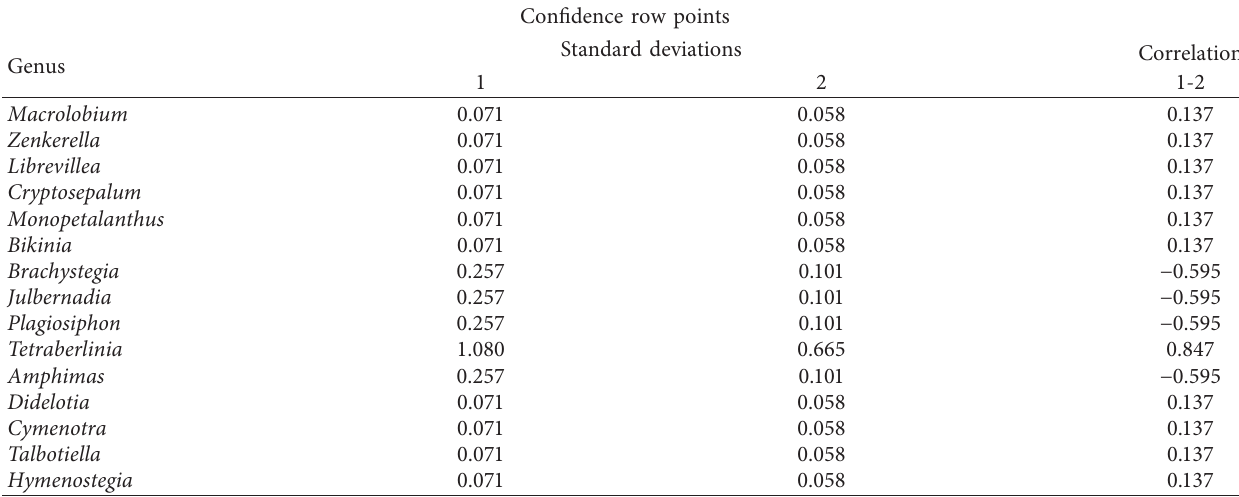
Table 1: Values of the mass coefficient of various genera.